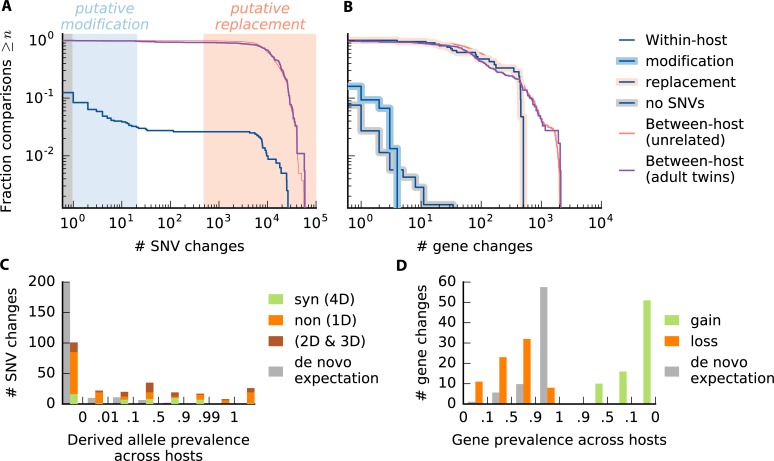
Within-host changes across prevalent species of gut bacteria.(a) Within-host nucleotide differences over 6-month timescales. The blue line shows the distribution of the number of single nucleotide variant (SNV) differences between consecutive quasi-phaseable (QP) time points for different combinations of species, host, and nonoverlapping time interval (if more than two samples are available) for the 45 prevalent species in S20 Fig. The distribution of the number of sites tested in each comparison is shown in S18 Fig. For comparison, the red line shows a matched distribution of the number of SNV differences between each initial time point and a randomly selected Human Microbiome Project host, and the purple line shows the distribution of the number of SNV differences between QP lineages in pairs of adult twins. The shaded regions indicate replacement events (light red, 3% of all within-host comparisons), modification events (light blue, 9% of within-host comparisons), and no detected changes (gray, 88% of within-host comparisons); these ad hoc thresholds were chosen to be conservative in calling modifications. (B) Within-host gene content differences (gains + losses). The blue lines show the distribution of the number of gene content differences within hosts for the samples in (A), with the putative modifications highlighted in light blue, the putative replacements highlighted in light red, and the samples with no SNV changes highlighted in gray. The distribution of the number of genes tested in each comparison is shown in S18 Fig. For comparison, the corresponding between-host and twin distributions are shown as in (A). (C) The total number of nucleotide differences at nondegenerate nonsynonymous sites (1D), 4-fold degenerate synonymous sites (4D), and other sites (2D and 3D) aggregated across the modification events in (A). Sites are stratified based on their prevalence across hosts (S1H Text). For comparison, the gray bars indicate the expected distribution for random de novo mutations (S1H text, part i). (D) The total number of gene loss and gain events among the gene content differences in (B), stratified by the prevalence of the gene across hosts. The de novo expectation for gene losses is computed as in (C); by definition, there are no de novo gene gains.